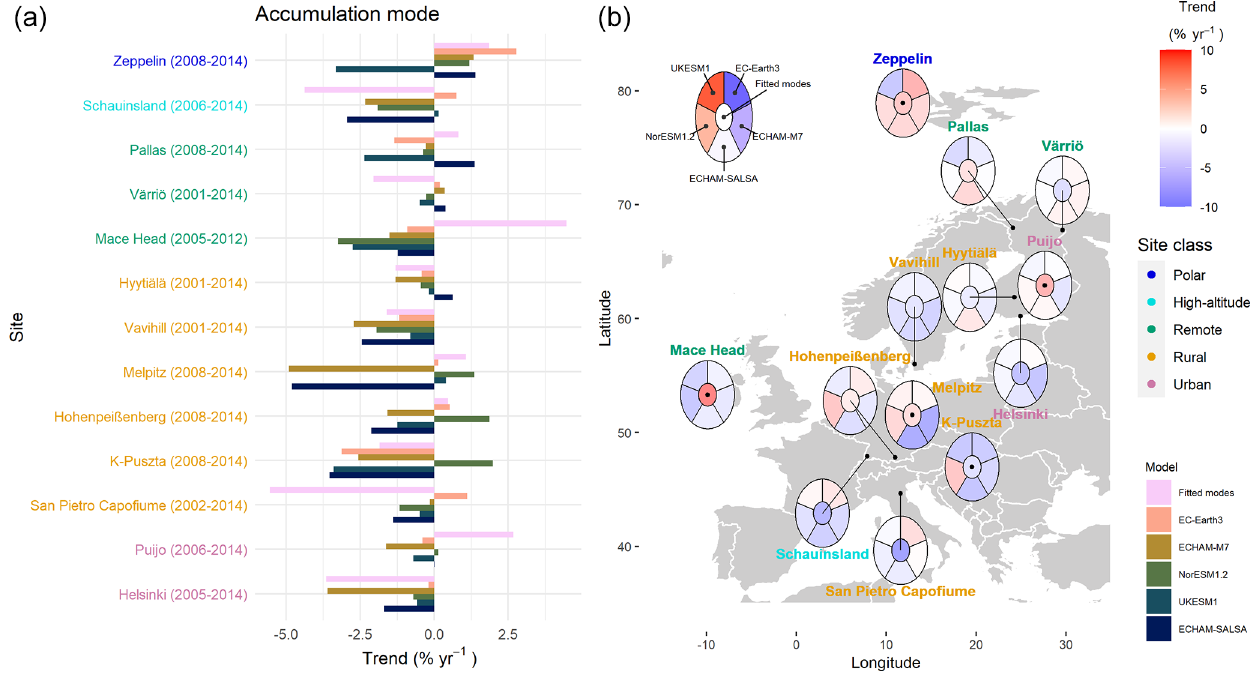
Figure 8. Long-term trend estimates for measured and modelled accumulation mode number concentration. (a) Bar plot of trends at different sites. Sites ( y axis) are arranged by site class and within each site class from north to south. (b) Estimated trends presented on the map. The colour of the central part follows the trend of the fitted modes. Trends have been calculated using the Sen–Theil estimator and complemented with bootstrap confidence intervals (see Sect.